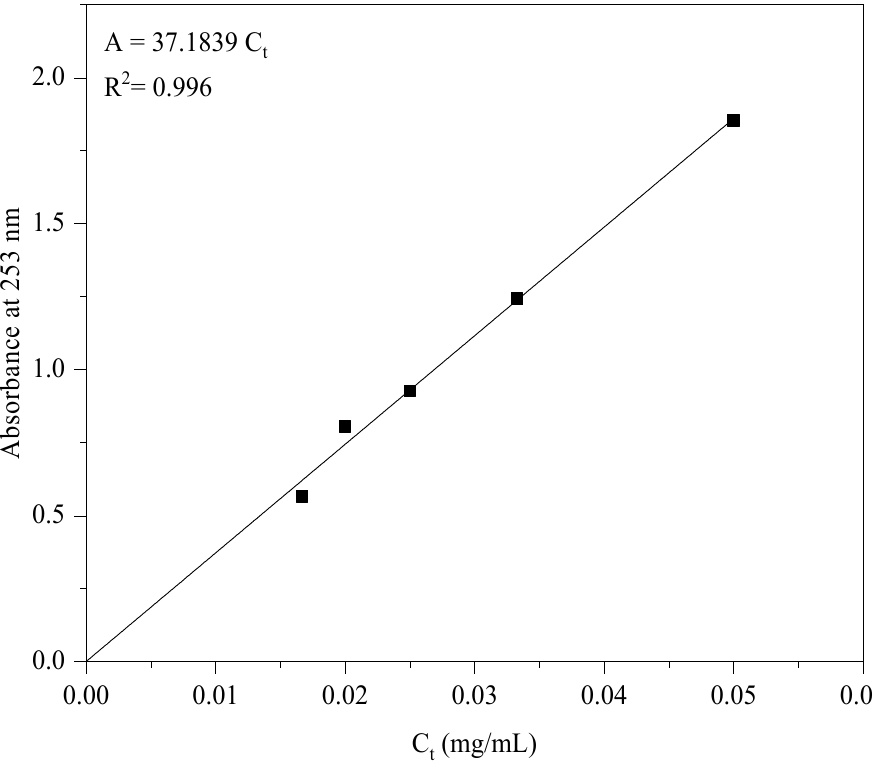
Figure 2. Correlation between absorbance at 253 nm and CNT concentration.